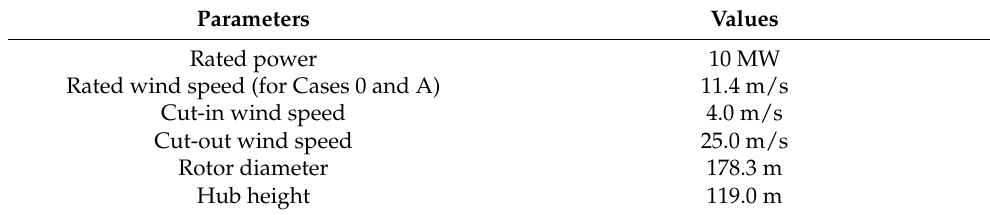
Table 1. Summary of turbine parameters.